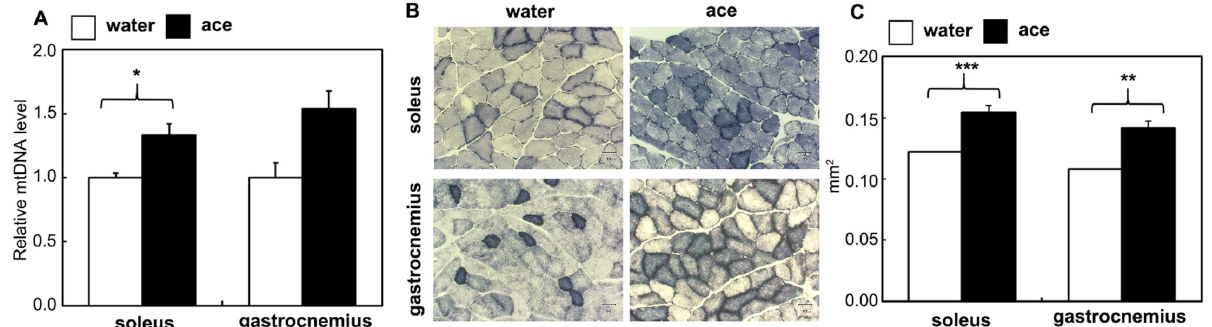
Figure 6. Effect of long-term supplementation of acetic acid on mitochondrial DNA (mtDNA) content ( A ), succinate dehydrogenase (SDH) staining ( B ), and Image J analysis of SDH staining ( C ) in the soleus and gastrocnemius muscles of SD rats at 56 weeks of age. A: Values represent means ± SE for 4 – 5 rats. * p < 0.05, ** p < 0.01, *** p < 0.001, statistically significant versus the value of water group. Results were analyzed with Student’s t -test.